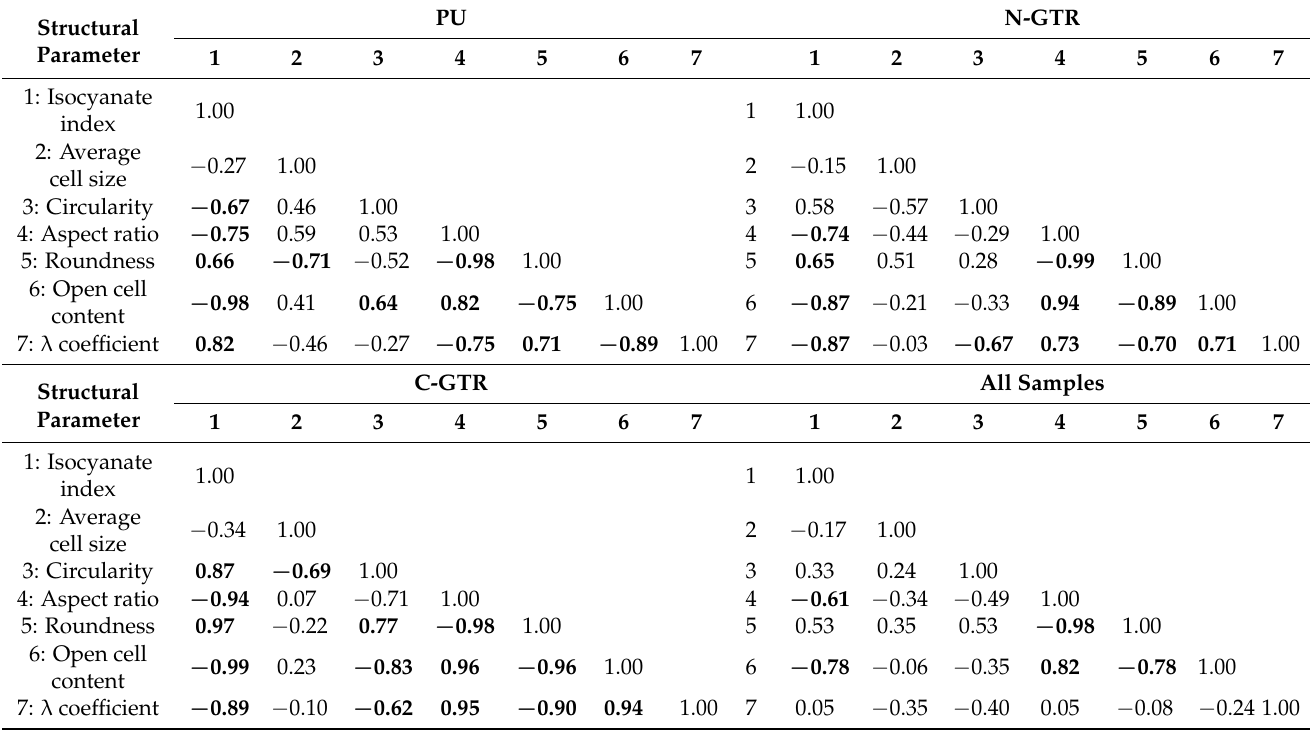
Table 3. PCC values quantify the strength of the relationship between particular structural parameters of prepared